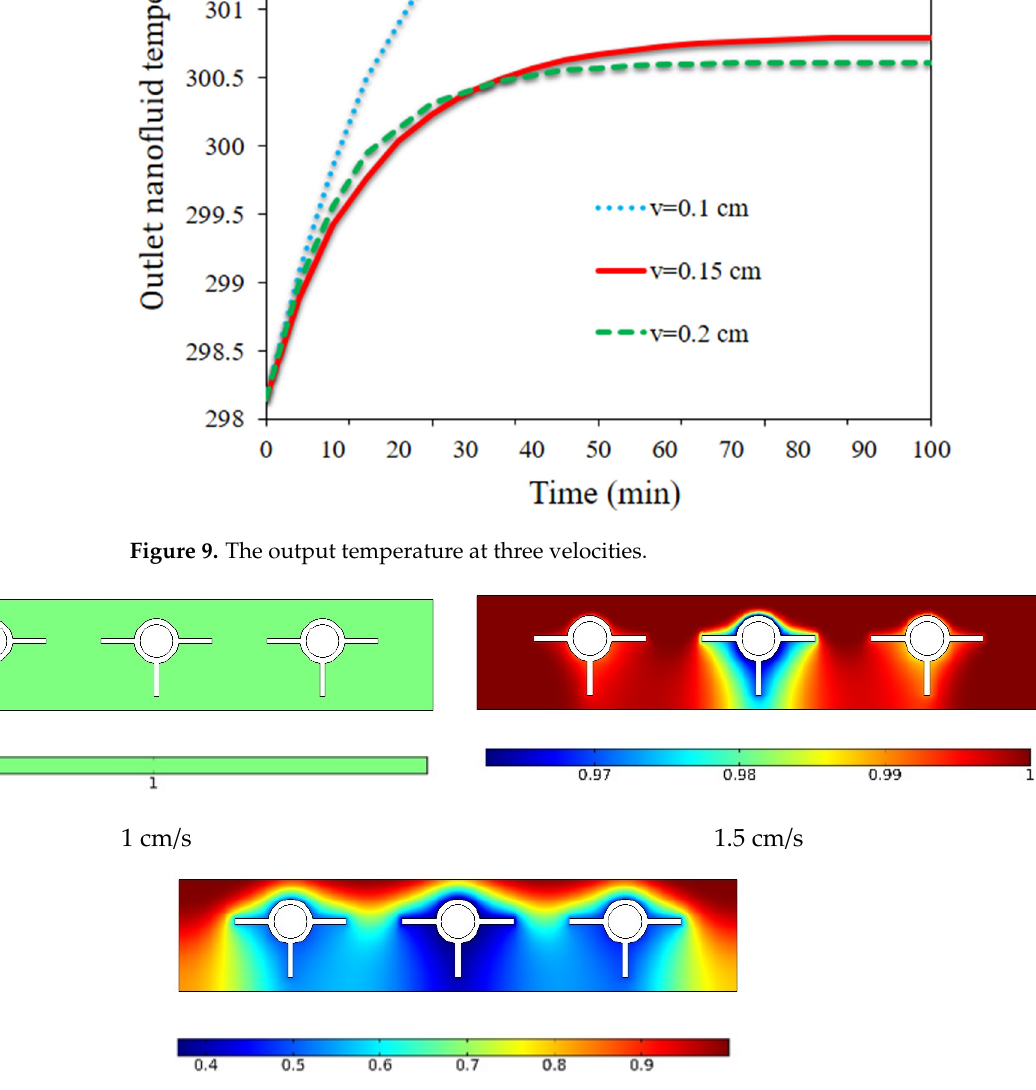
Figure 9. The output temperature at three velocities.